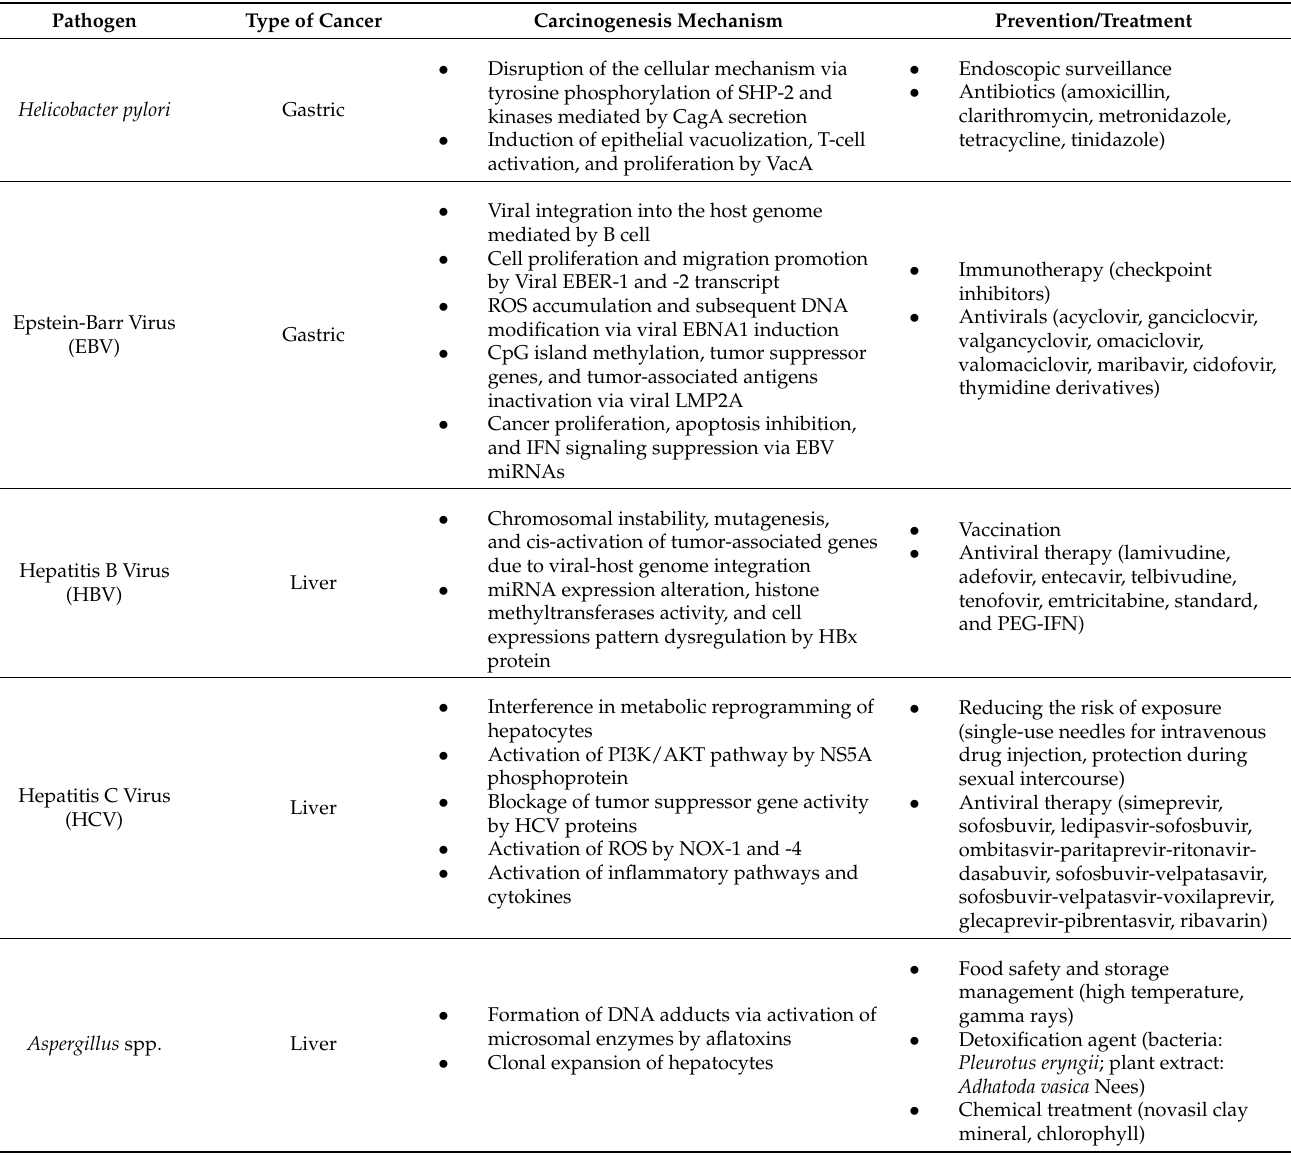
Table 1. Carcinogenesis mechanism and prevention/treatment strategies for infection-associated